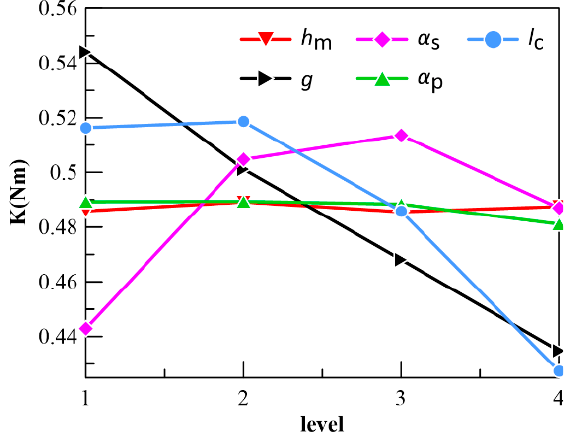
Figure 16. The curves of the variation of K values for each factor at each level.